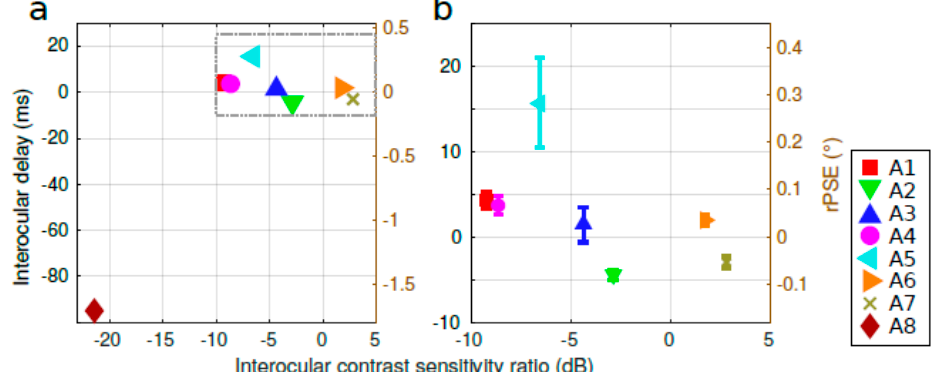
Figure 4. Correlation between the observed interocular delay and the interocular contrast sensitivity ratio. ( a ) Interocular delay as a function of the interocular contrast sensitivity ratio at the same spatial frequency of the Gabor patches used in the stimulus for all subjects. Coefficient of determination R 2 = 0.5641, p = 0.0317. ( b ) Inset of the dotted frame area of ( a ) excluding subject A8. Coefficient of determination R 2 = 0.2677, p = 0.2343.